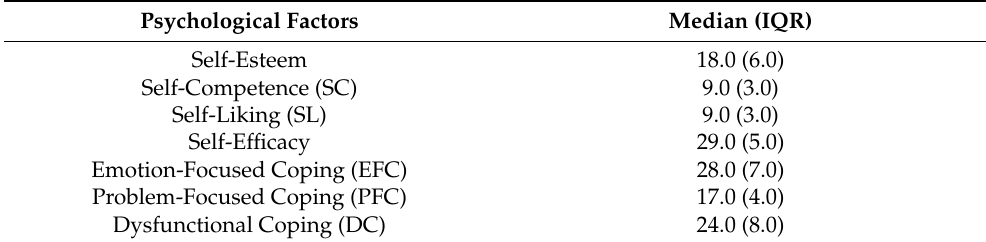
Table 2. Psychological Factors among Medical